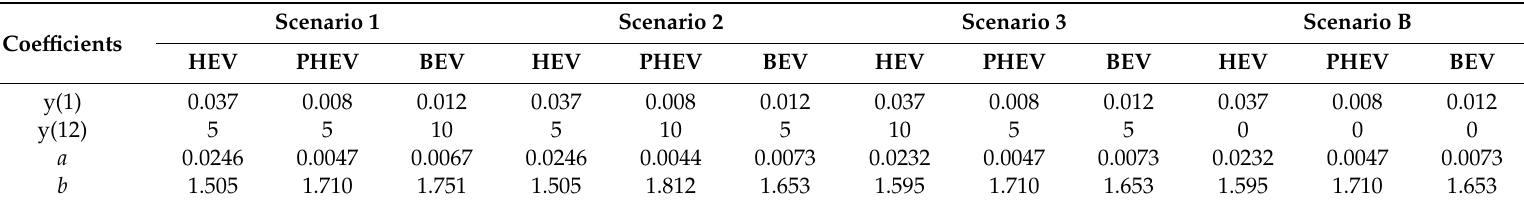
Table 2. Coe ffi cients used in determining di ff erent scenarios ( y ( x )) of projected market penetration of electric vehicles in Gauteng from 2018 to